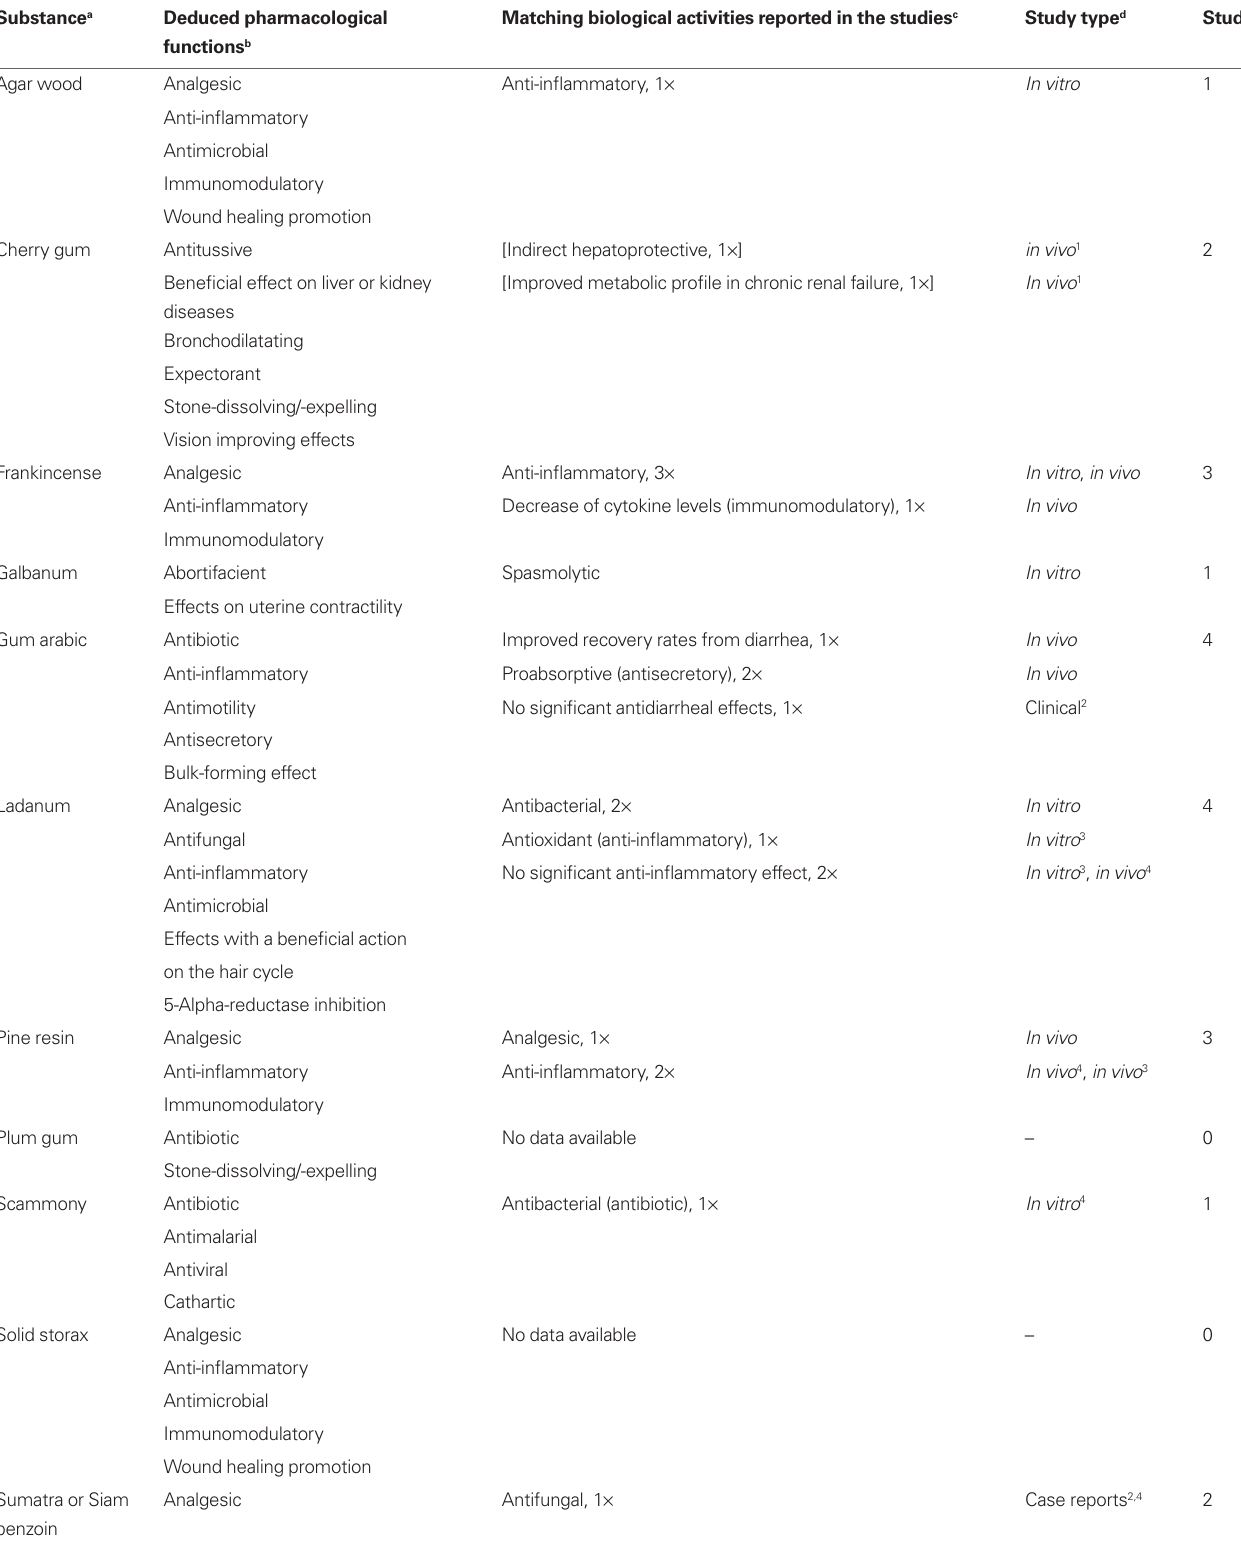
Table 6 | Cross-referencing of deduced pharmacological functions to reported biological